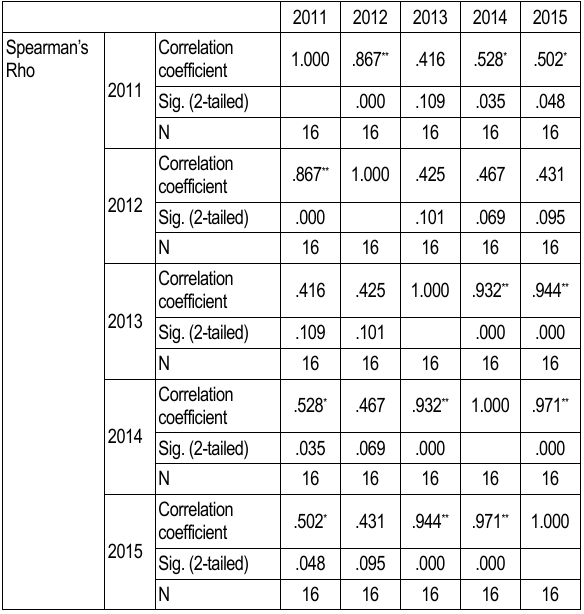
Table 4. Spearman’s Rho